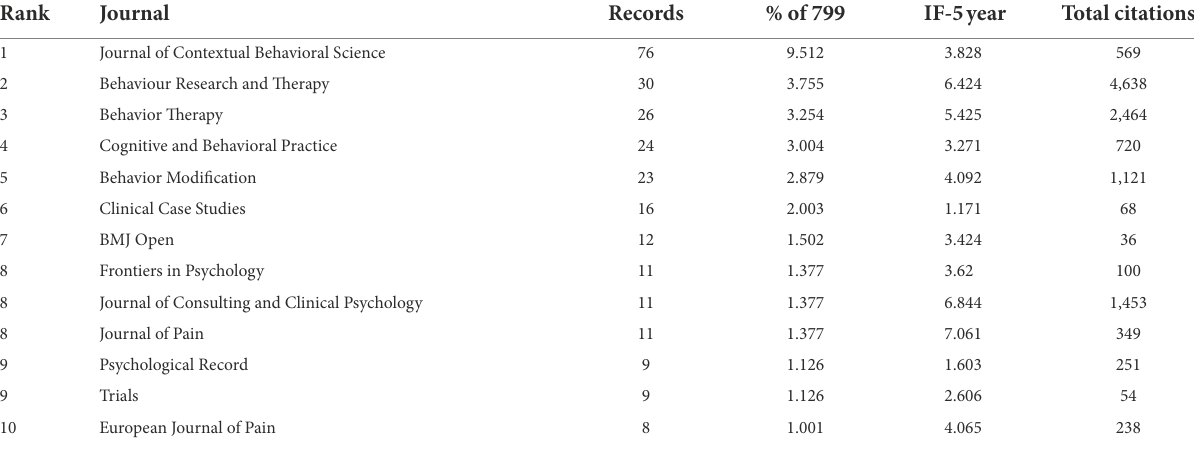
TABLE 1 The top 10 most productive journals in ACT